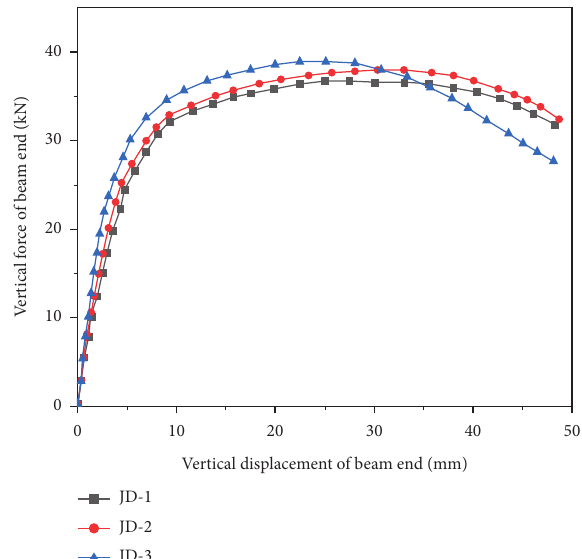
Figure 14: The skeleton curves of different sleeve diameters.